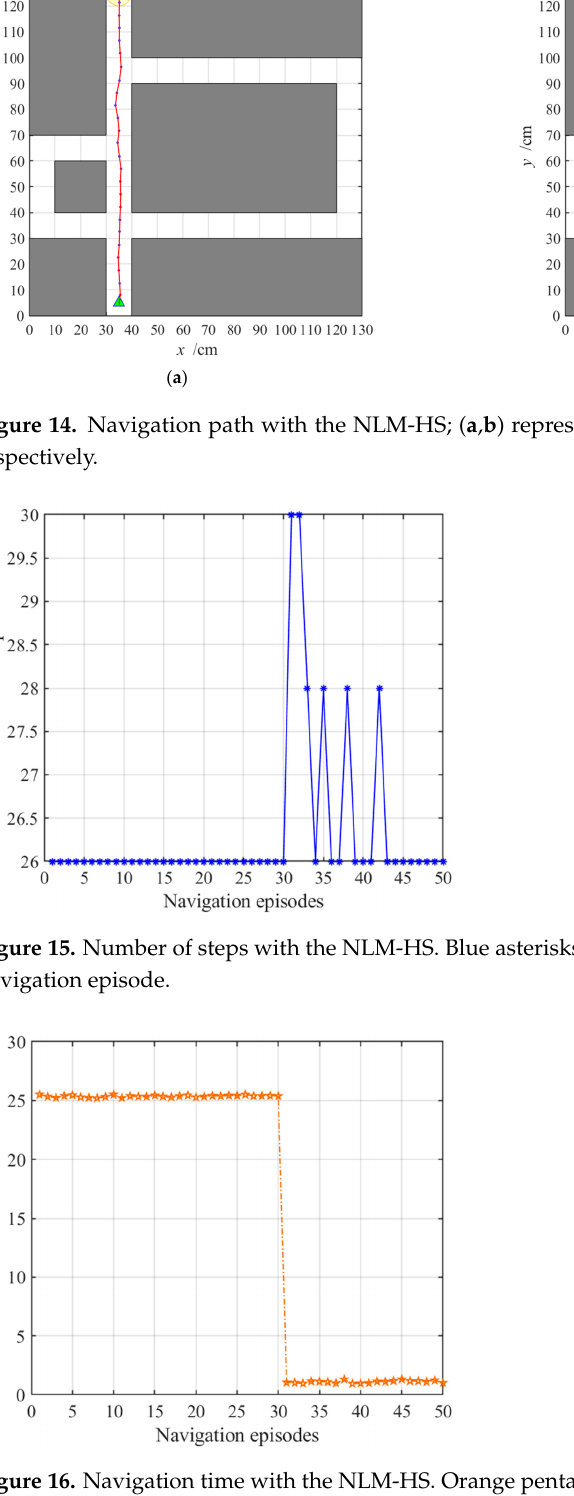
Figure 16. Navigation time with the NLM-HS. Orange pentagrams indicate the navigation time for each navigation episode.